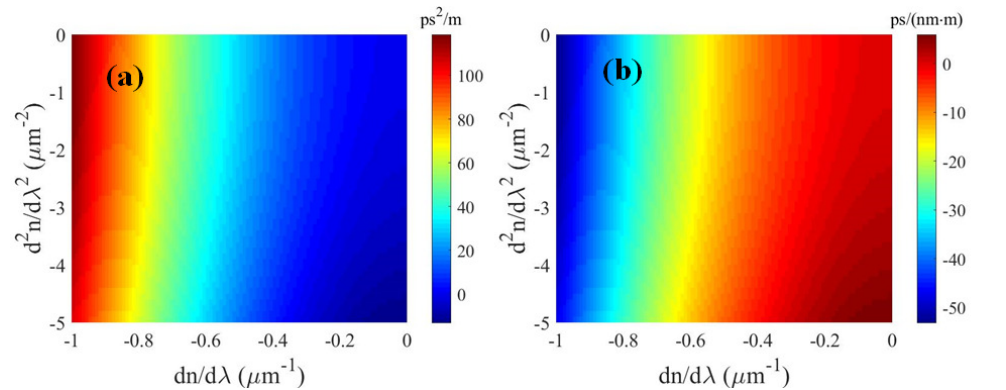
Figure 15. Prismatic dispersion of prism pairs with varying refractive index dispersion: ( a ) Second-order dispersion β 2 , and ( b ) dispersion constant D. The wavelength of the light beam and propagation angle are 2.05 µ m and 0.5 ◦ ,